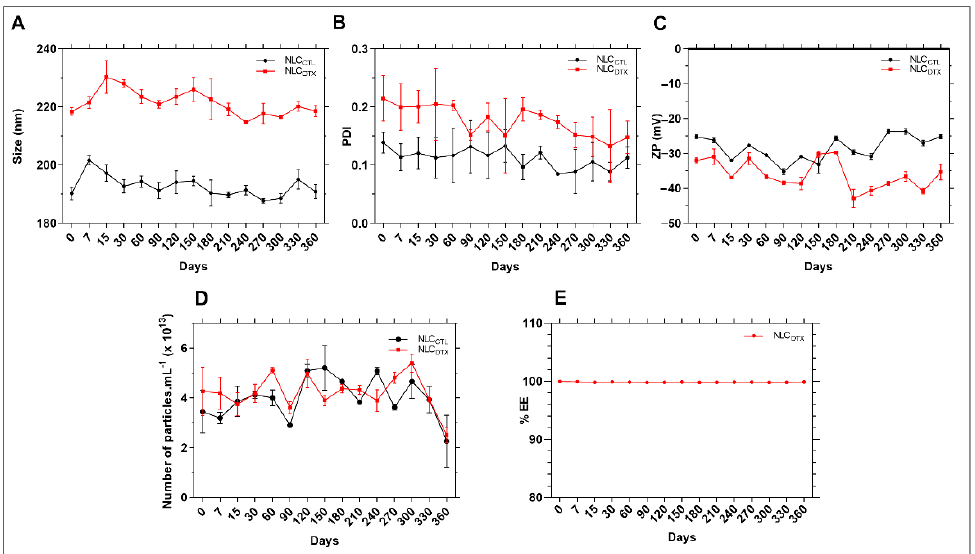
Figure 5. Stability data of NLC CTL and NLC DTX formulations in relation to ( A ) size, ( B ) PDI, ( C ) ZP, ( D) number of particles/mL and ( E ) DTX encapsulation efficiency (% EE), during 12 months of storage at 25 ◦ C. Two-way ANOVA plus Tukey-Kramer post hoc tests revealed no statistical